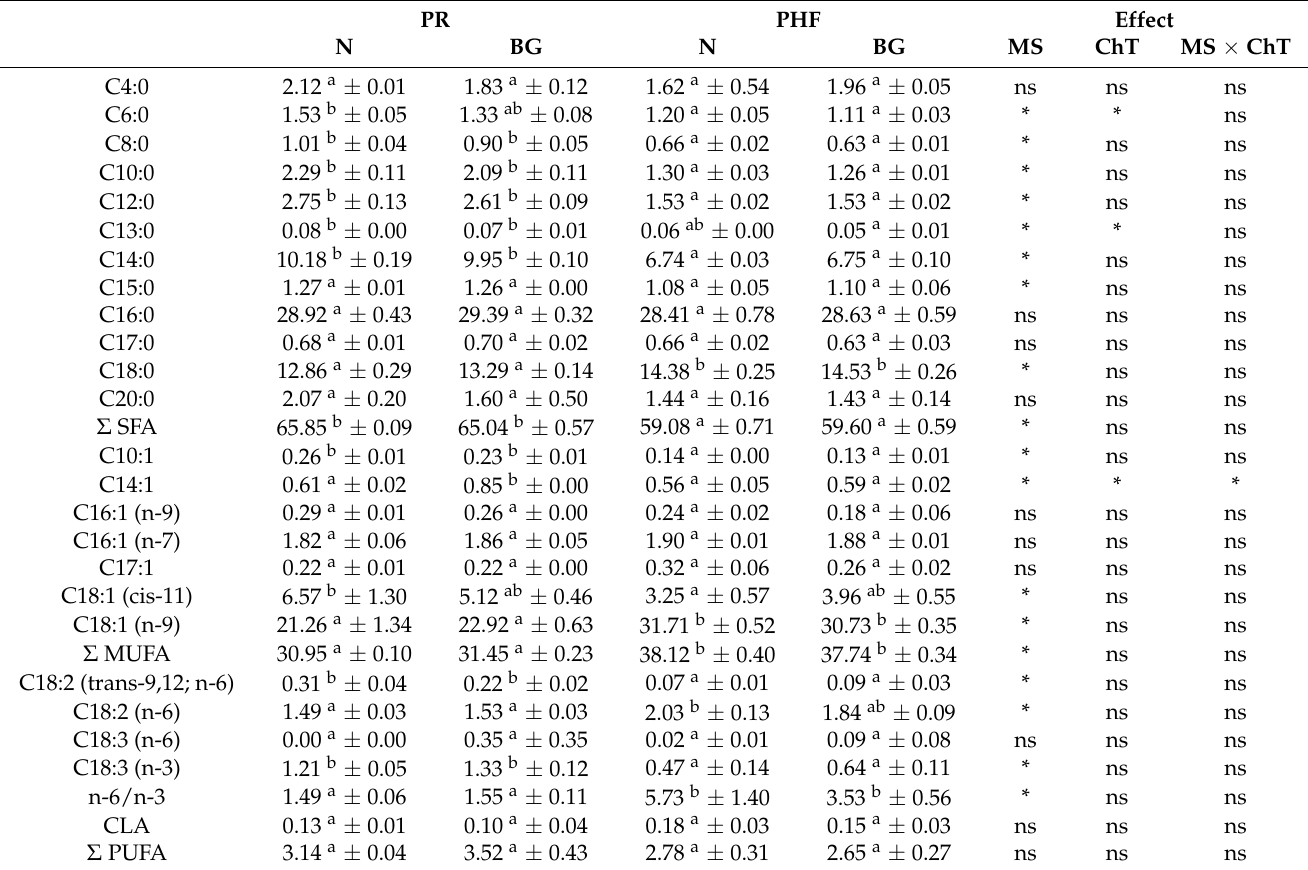
variability factors found for the concentration of myristoleic acid confirmed that the herbal addition differently influenced its level in PR and PHF cheeses. Table 3. Fatty acid profile (%) in the analyzed fresh cheeses (average ± SE, n = 4). PR PHF Effect N